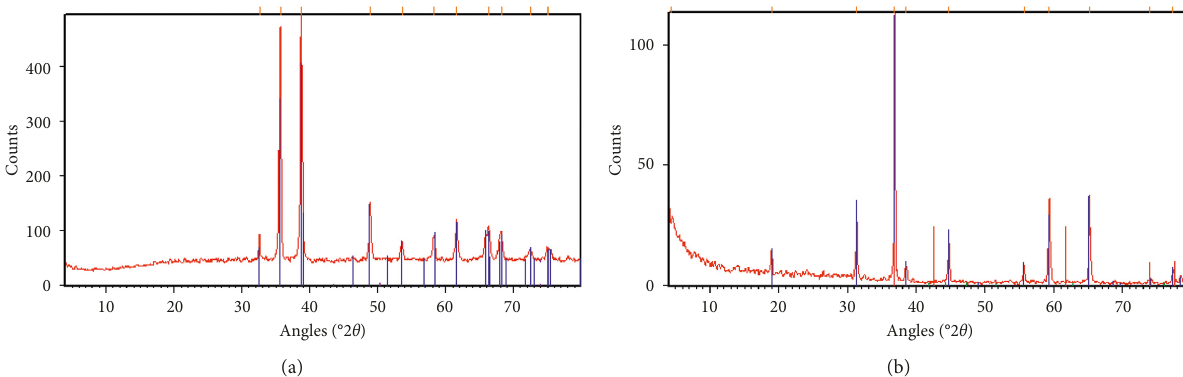
Figure 7: XRD pattern of (a) copper oxide, CuO, and (b) cobalt oxide, Co metal glutamic arginine mixed ligands